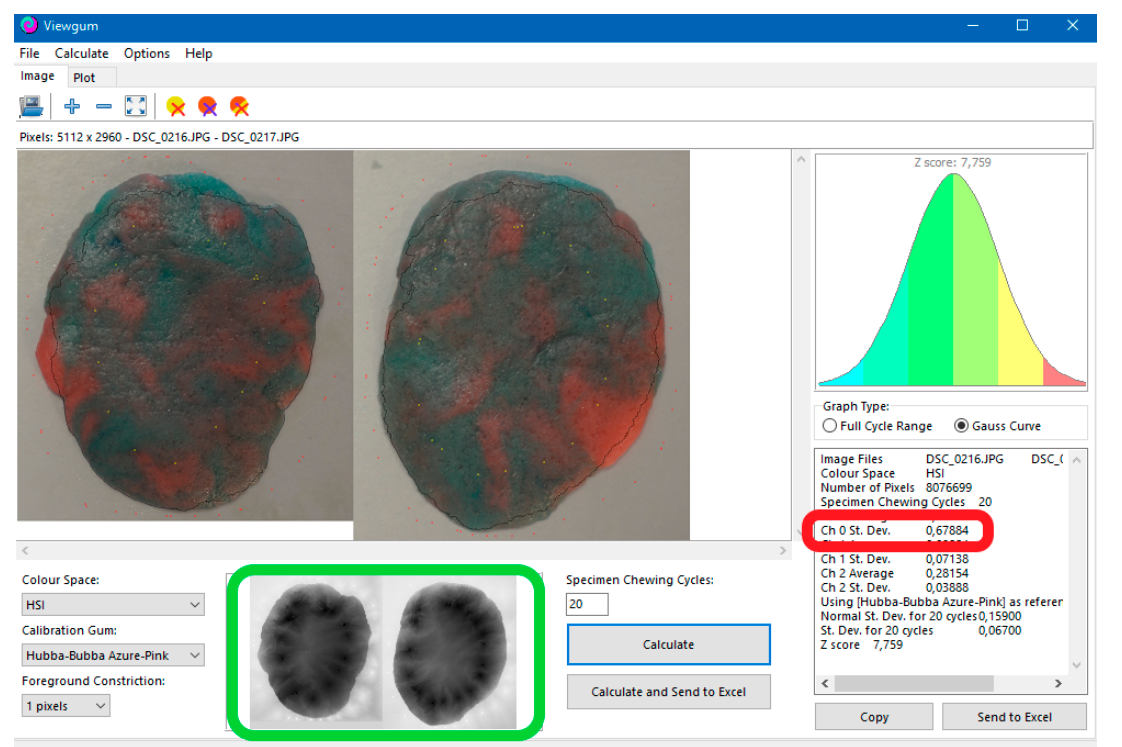
Figure 5. ViewGum© software user interface immediately after loading two images of a chewed gum sample for 20 mastication cycles. The images were obtained by scanning both sides of the flattened gum. The software separates the area of interest from the background as shown by the thumbnail images (green circle). Mouse tracks (yellow and red dots in the main images) can be added or deleted for segmentation. The numerical results are displayed on the right. The VOH value (displayed as “Ch 0 St. Dev” and indicated by an orange box) are calculated; higher VOH correspond to poorer chewing capacity (low color mix).